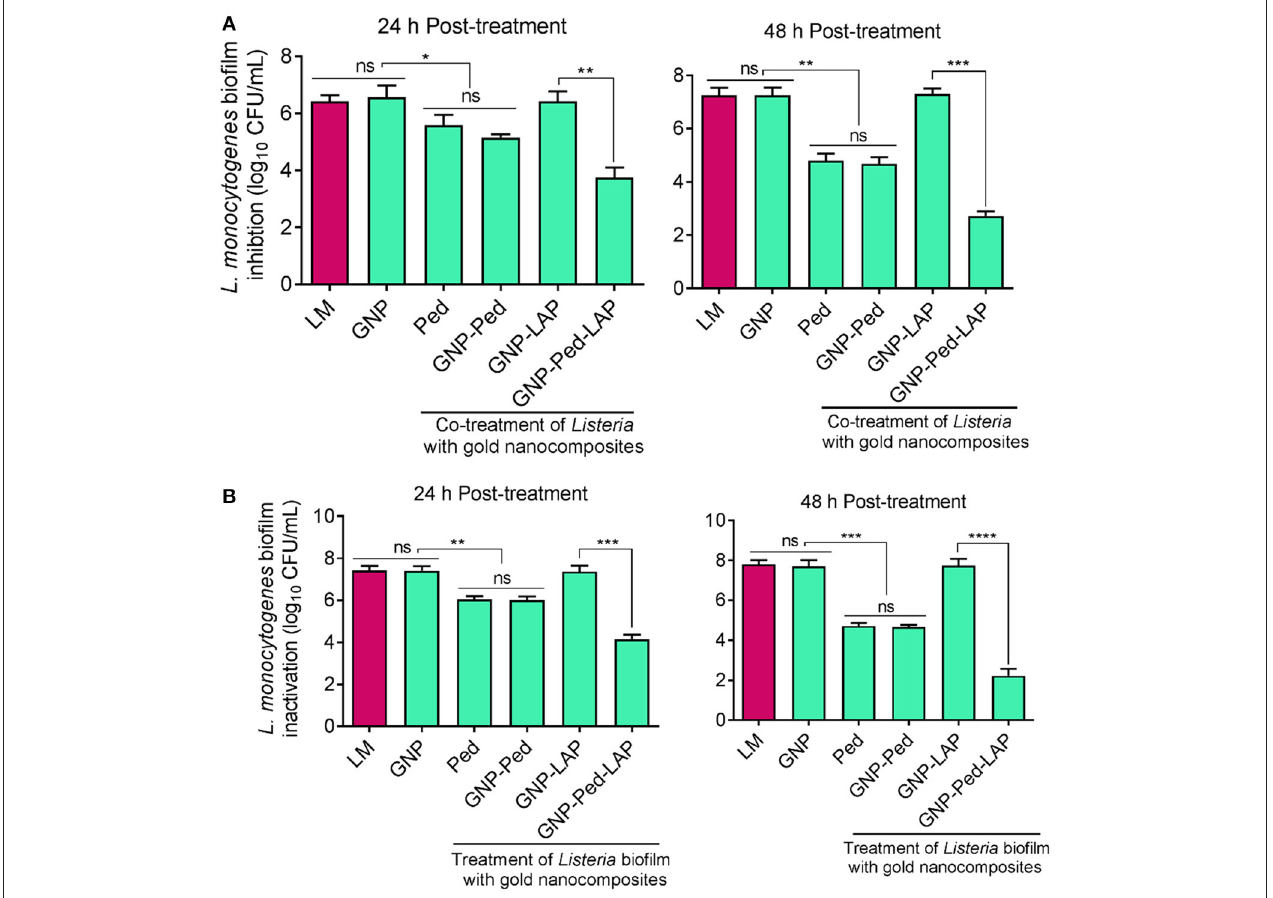
FIGURE 5 | Assessment of antibiofilm activity of gold nanoconjugates. (A) Prevention of L. monocytogenes biofilm formation using nanoconjugates. Both L. monocytogenes and gold nanoconjugates were inoculated simultaneously and Listeria growth in the biofilm was monitored at 24 and 48h. (B) Inactivation of L. monocytogenes cells in the pre-formed biofilm with nanoconjugates. L. monocytogenes cells were allowed to form biofilm for 24h and then treated with gold nanoconjugates for 24h and 48h prior to L. monocytogenes enumeration. Data are average of three experiments analyzed in triplicate. **** P < 0.0001; *** P < 0.001; ** P < 0.01; * P < 0.05; ns, no significance. Lm, Listeria monocytogenes ; GNP, gold nanoparticle; Ped, Pediocin; LAP, Listeria adhesion